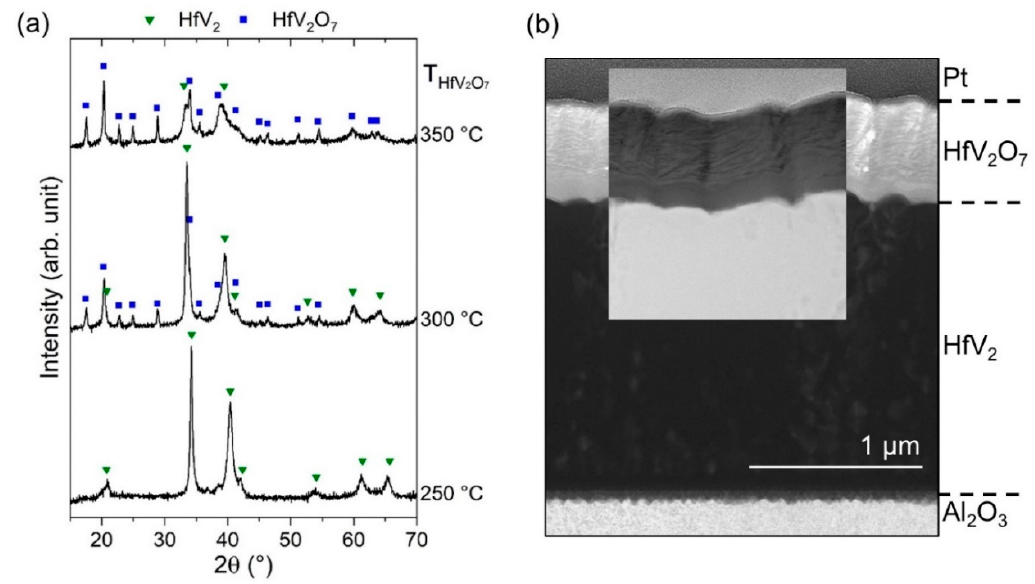
Figure 8 . ( a ) Diffractograms of magnetron sputtered HfV 2 –HfV 2 O 7 bilayers. The synthesis temperature T for HfV 2 O 7 on HfV 2 has been varied between 250 and 350 °C. ( b ) Scanning transmission electron microscopy bright-field with inset high-angle annular dark-field image of HfV 2 –HfV 2 O 7 cross-section with HfV 2 O 7 having been synthesized at 300